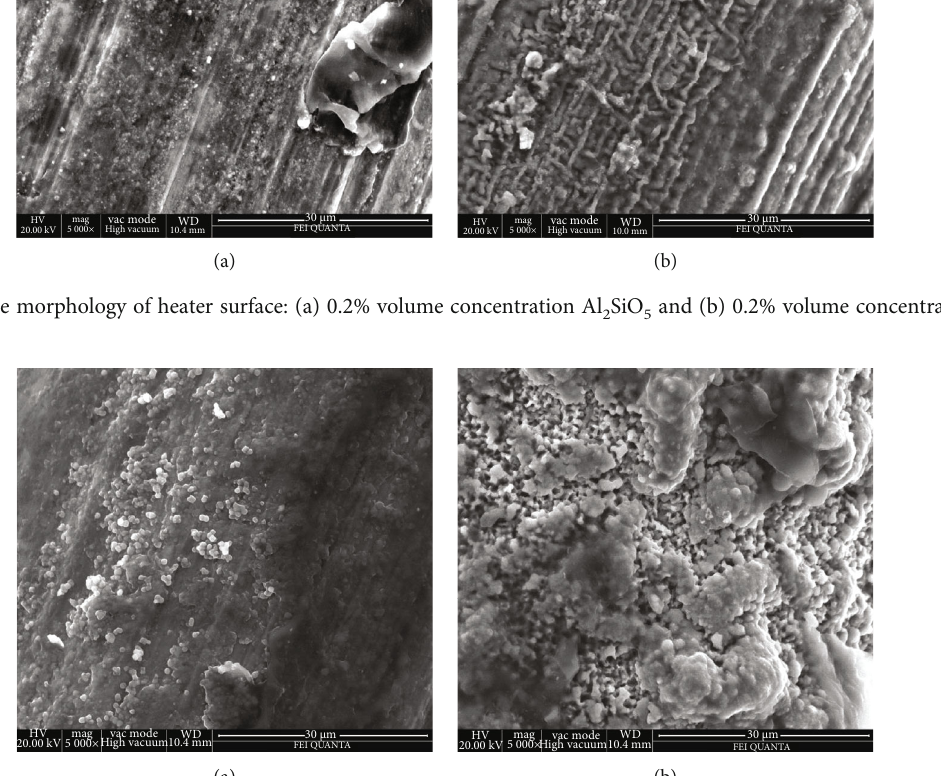
SiO and (b) 0.3% volume concentration CeO 2 5